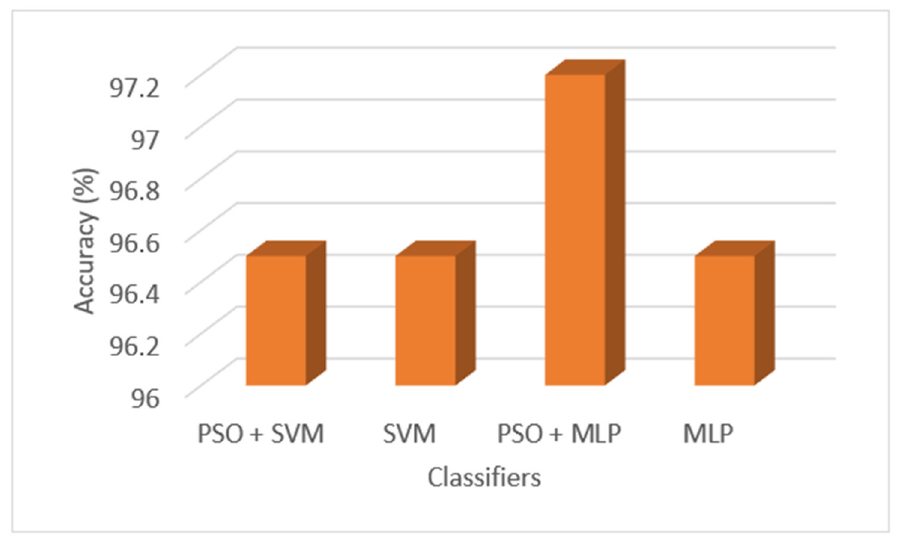
Figure 4. Accuracy (%) vs. Classifier.